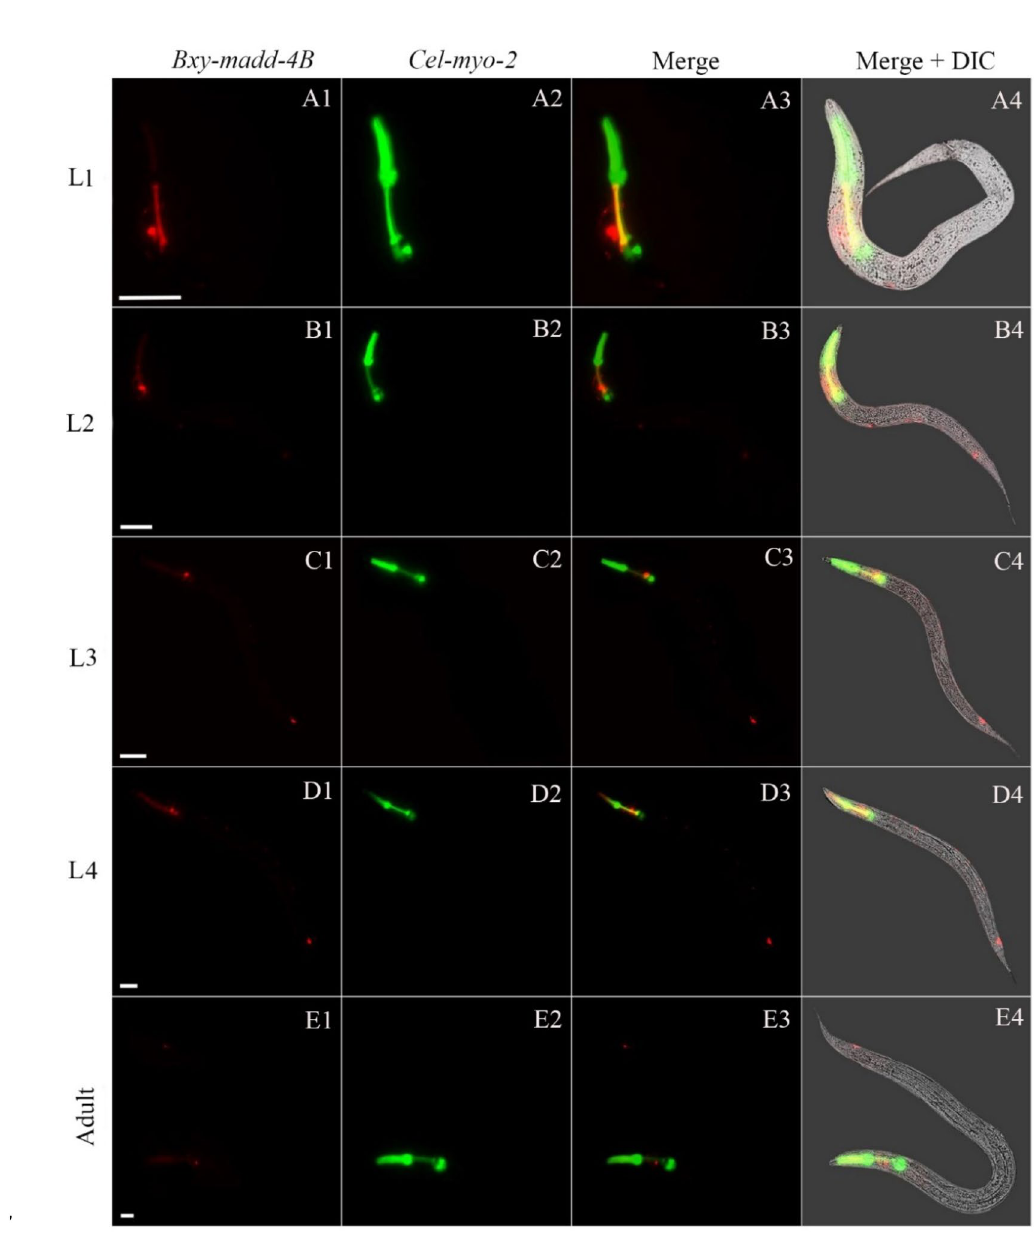
Figure 7. The localization of Bxy-madd-4B on translational level transgenic C. elegans during postembryonic development. The expression patterns of mCherry (red) under control of B. xylophilus madd-4B promoter and green fluorescent protein gene (green) was driven by C. elegans promoter myo-2 as a marker for pharynx development. Fluorescent and differential interference contrast (DIC) merged microscope images of the second filial generation transgenic C. elegans carrying both Bxy-madd-4Bp ::mCherry and Pmyo-2 ::GFP transgenes. L1, first-stage juvenile (A1–A4); L2, second-stage juvenile (B1–B4); L3, third-stage juvenile (C1–C4); L4, fourth- stage juvenile (D1–D4); and adult hermaphrodite (E1–E4). In each age group, 50 nematodes were examined. The scale bar stands for 20 cinerea at 25 °C in the dark in the PDA plates for 48 h to collect synchronized male and female J4 under an opti- cal microscope Zeiss Observer (Carl Zeiss, Oberkochen, Germany). To obtain virgin adult males and females, the synchronized male and female J4 were cultured on the B. cinerea at 25 °C for 24 h, respectively 38 . B. xylophilus under different light sources. To investigate the effects of different light resources on the development of B. xylophilus , 10 pairs of virgin adult males and females (10 ♀ + 10 ♂ ) were inoculated onto the mycelia of B. cinerea and placed under different light-emitting diode (LED), including red, orange, yellow, green, blue, violet and white (1000 lx), at 25 °C for 7 days. Besides, dark was used as a control. The effects of the different light sources on the development of B. xylophilus were assessed by comparative fecundity between the dark and the different light sources treated nematodes.